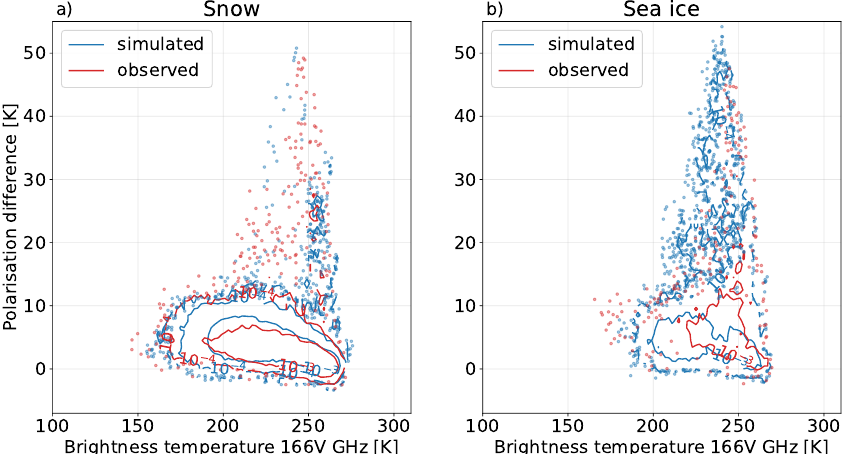
Figure 6. The same as in Figure 4, but for snow covered land ( a ) and sea ice ( b ). For sea ice, the structure of PDs was only slightly different from snow cover. Here, the flat arch region was narrower and the concentration of observations along the arm was denser than for snow covered land. The PDs along the arch region originated from snow covered sea ice, while the higher PDs along the arm arose from a sea ice and water mixture. The differences in the radiometric responses of open water and sea ice led to varying surface emissivities over mixed surface types. Since the emissivity of water is much higher than sea ice, satellite footprints with lower sea ice fractions have higher emissivity than areas with larger sea ice fractions. A detailed description of the distribution of the sea ice and water mixture inside the footprint is required to model these emissivities